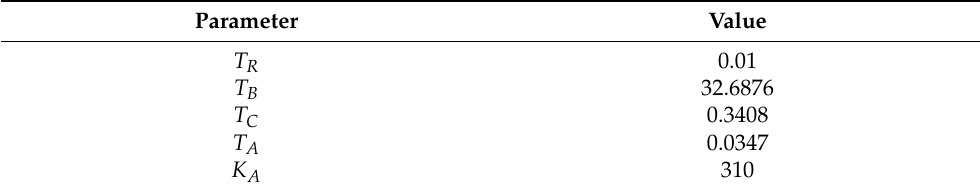
Figure 8. Final result after identification process where the dashed blue line indicates the step in the reference voltage and the black and red line the measured and simulated field voltage. Table 4. Estimated parameters of the excitation system IEEE AC4A.